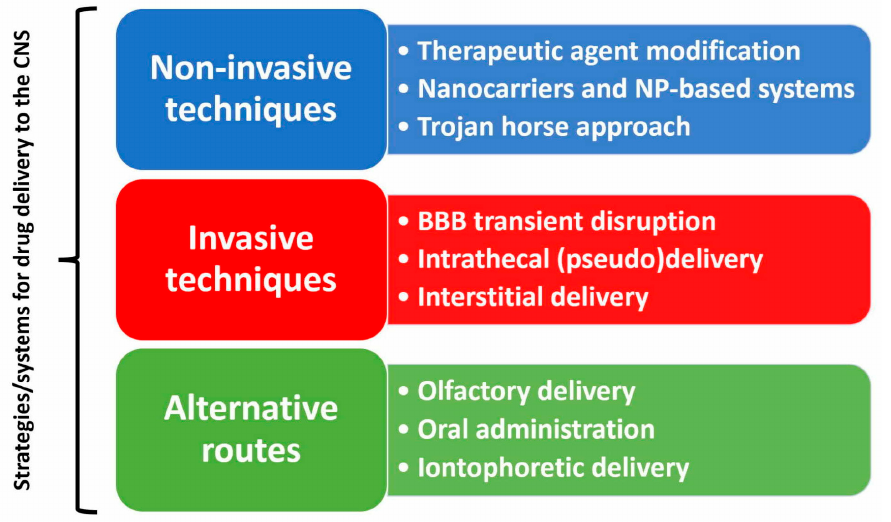
Figure 3. Current strategies/systems for drug delivery to the CNS. (Color code: blue—non-invasive methods, red—invasive methods, green—alternative methods; Abbreviations: BBB—blood-brain barrier; CNS—central nervous system; NP—nanoparticle).